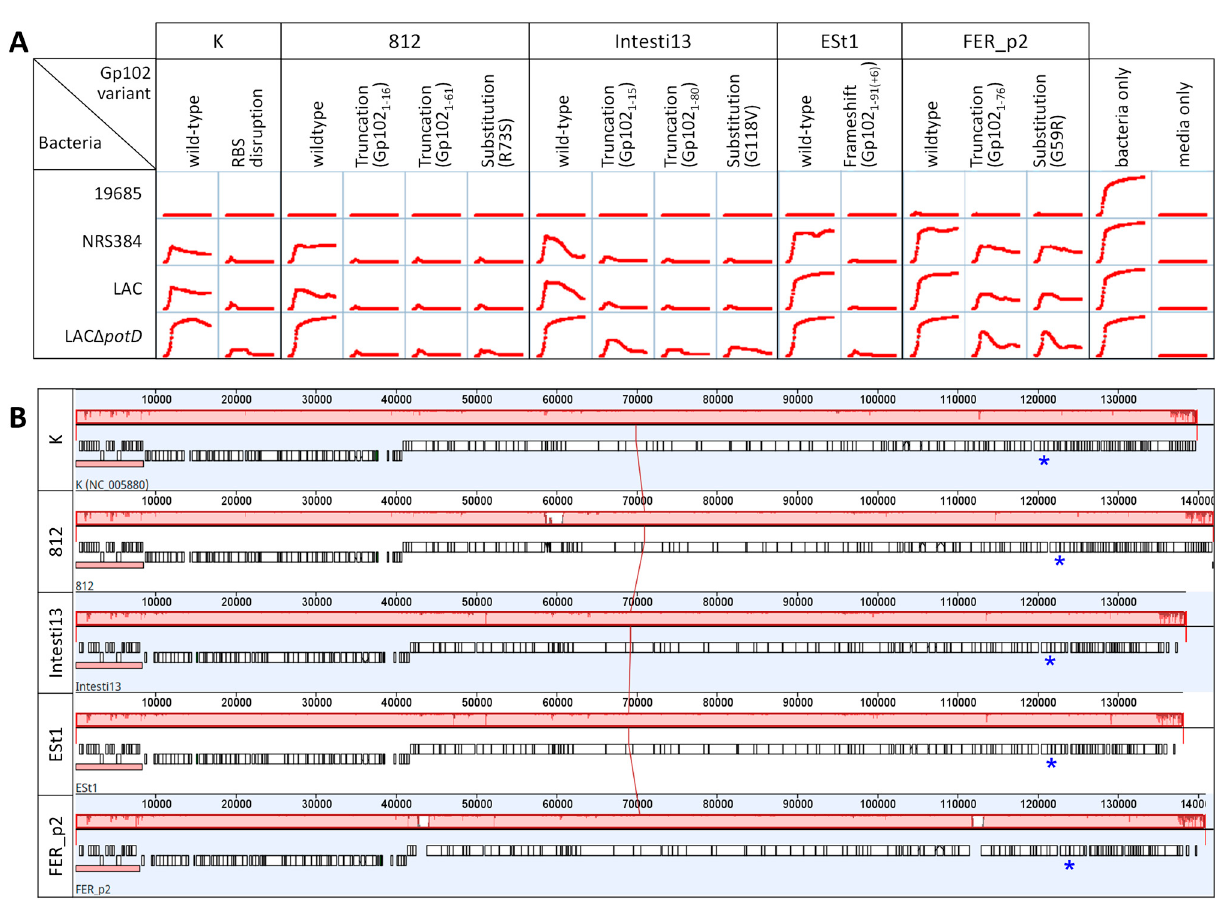
Figure 4. Four Kayvirus phages that have gp102 homologs identical to K show the same temperature- sensitive plaquing and growth suppression phenotypes on USA300 strains. As with K, this phenotype could be suppressed by loss-of-function mutations in the gp102 homolog. ( A ) Effect of these gp102 mutations on phage activity in broth at 37 °C. Gp102 1-91(+6) indicates a frameshift in codon 92 that creates a downstream stop codon; the protein therefore consists of the first 91 amino acids of Gp102 plus 6 others not usually encoded. ( B ) Intergenomic similarity of the single-copy genomes of parent phages from A, using Mauve. The large blocks of pink indicate nucleotide-level identity among all five phages; red dips and large white gaps indicate regions where the phage genomes differ. Genomes from top to bottom are K (NC_005880), 812 (MH844528), Intesti13, ESt1, and FER_p2. To aid visual comparison, gene annotations were transferred from K onto Intesti13, ESt1, and FER_p2 if there was at least 70% nucleotide similarity. The gp102 homologs are marked by the blue asterisk.